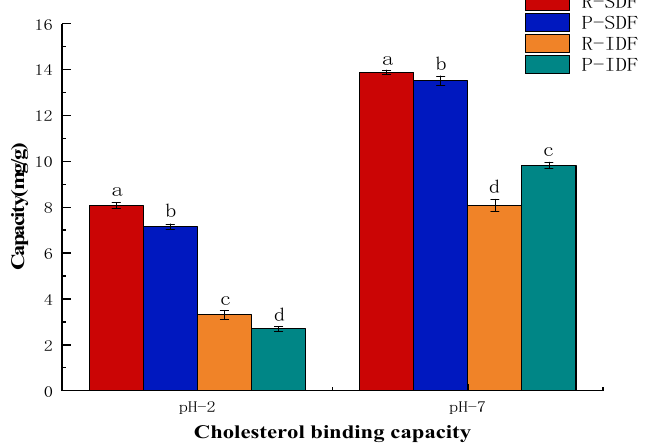
Figure 4. The CAC of R-IDF, P-IDF, R-SDF, P-SDF. R-SDF represents the residue soluble fiber; P-SDF represents the peel soluble fiber; R-IDF represents the residue insoluble fiber; P-IDF represents the peel insoluble fiber; values with different letters (a, b, c, d) for IDF or SDF are significantly different means ( p < 0.05).